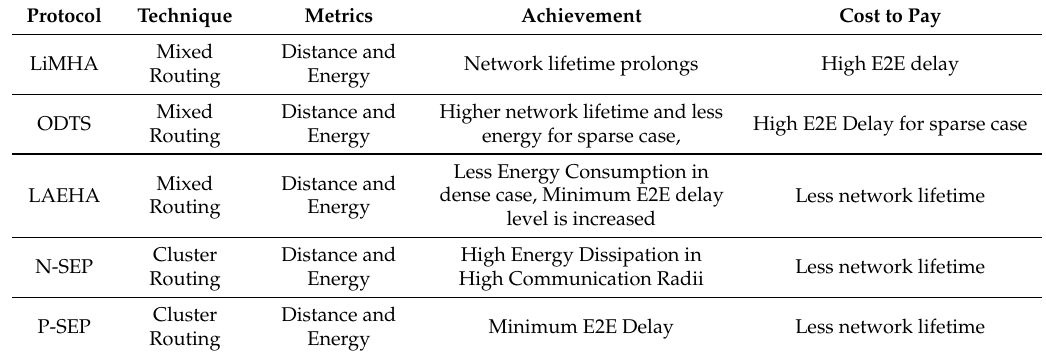
Table 3. Performance Trade